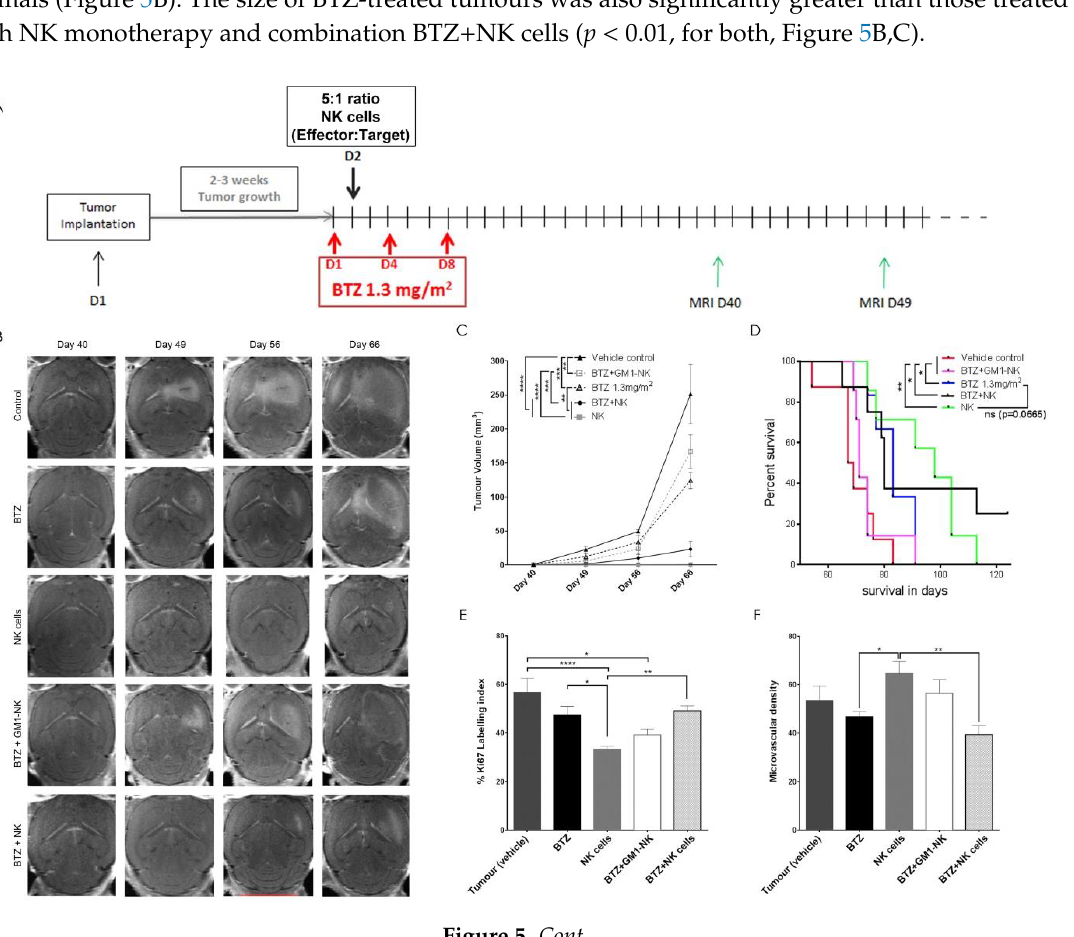
Figure 5. Figure 5. Cont.